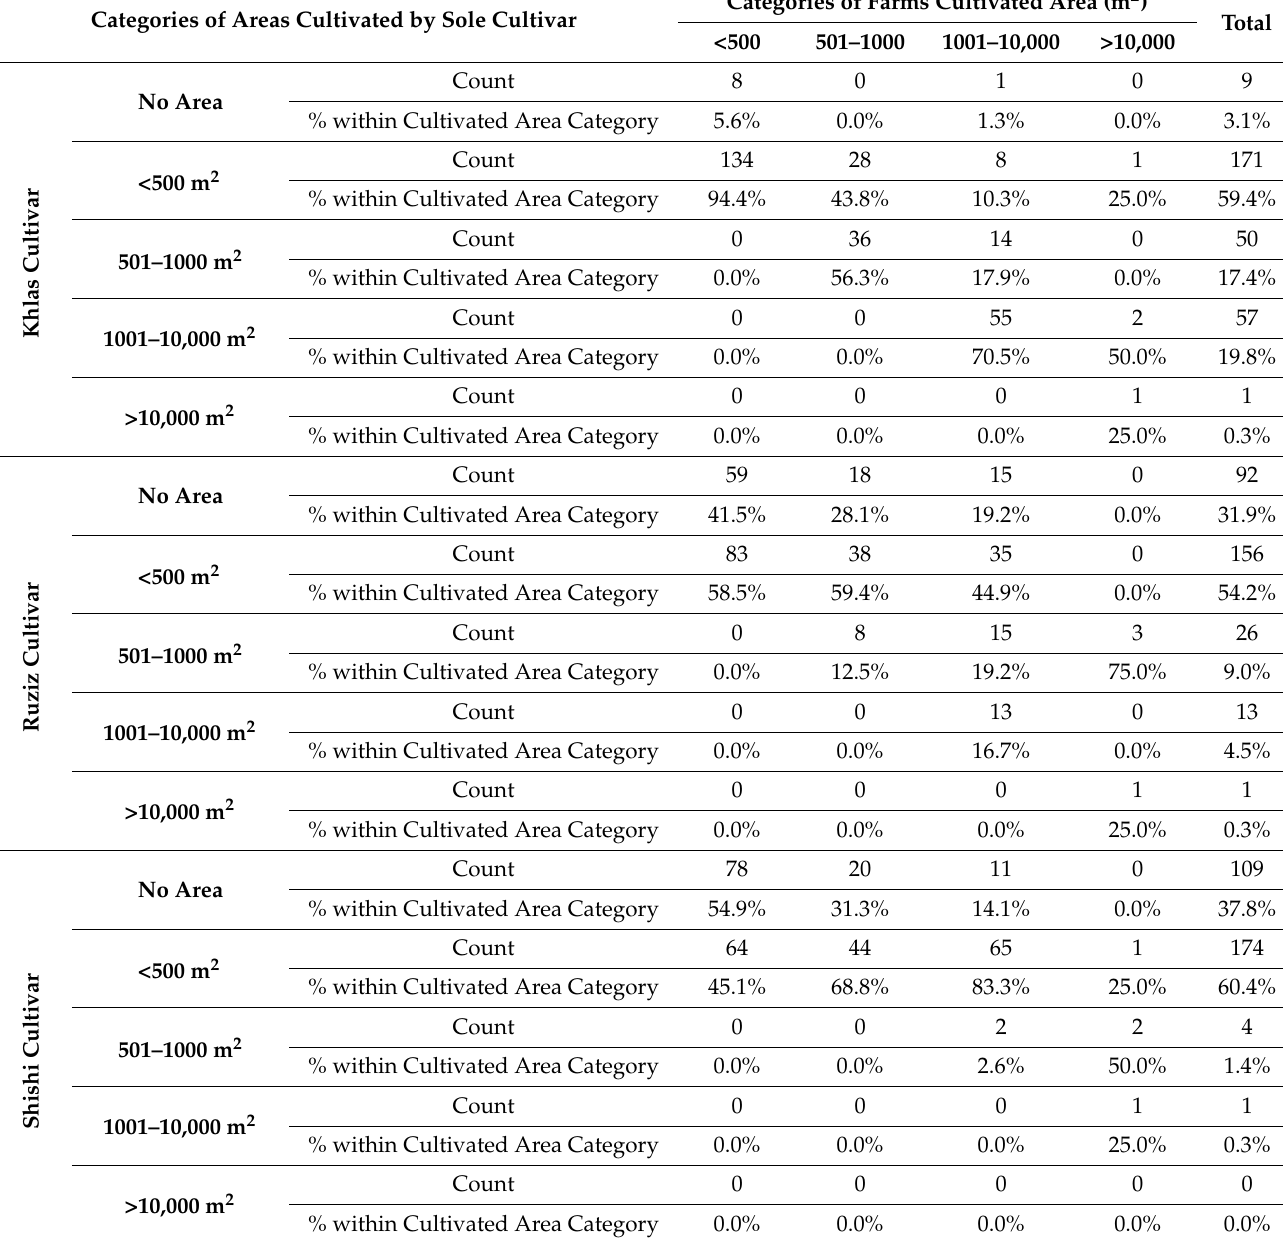
Table 3. The categorical correlation between total areas cultivated by sole cultivars and farms’ cultivated